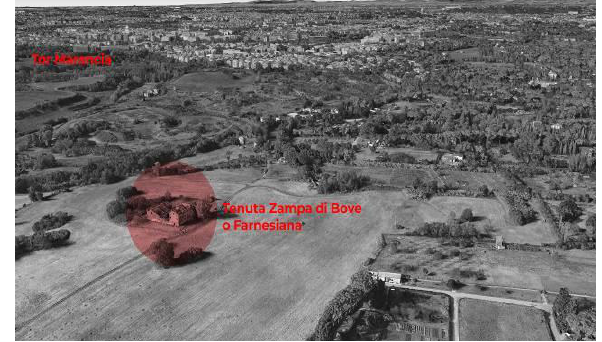
Figure 4. View of the Capo di Bove estate, in the direction of the historic center of Rome. On the left is the Tor Marancia estate, also of considerable